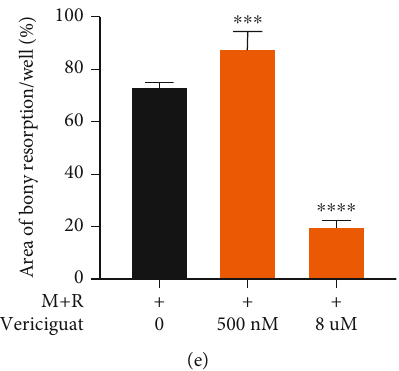
Figure 3: Vericiguat dually regulated the formation of F-actin ring and bony resorption of osteoclasts. (a) Representative images of F-actin- stained osteoclasts under the stimulation of RANKL for 7 d with 500nM and 8 μ M Vericiguat, respectively. (b) The average number and area of F-actin ring (c) ( n = 3 ). (d) Representative images of bony resorption (white area circled by a red dotted line) by mature osteoclasts. (e) The bony resorption area was quanti fi ed. Values are presented as the mean ± standard deviation ( n = 3 ). ∗ indicated a comparison with the control group (Vericiguat, 0 nM): ∗ p < 0 : 05 , ∗∗ p < 0 : 01 , ∗∗∗ p < 0 : 001 , and ∗∗∗∗ p < 0 : 0001 . Scale bar = 500 μ m